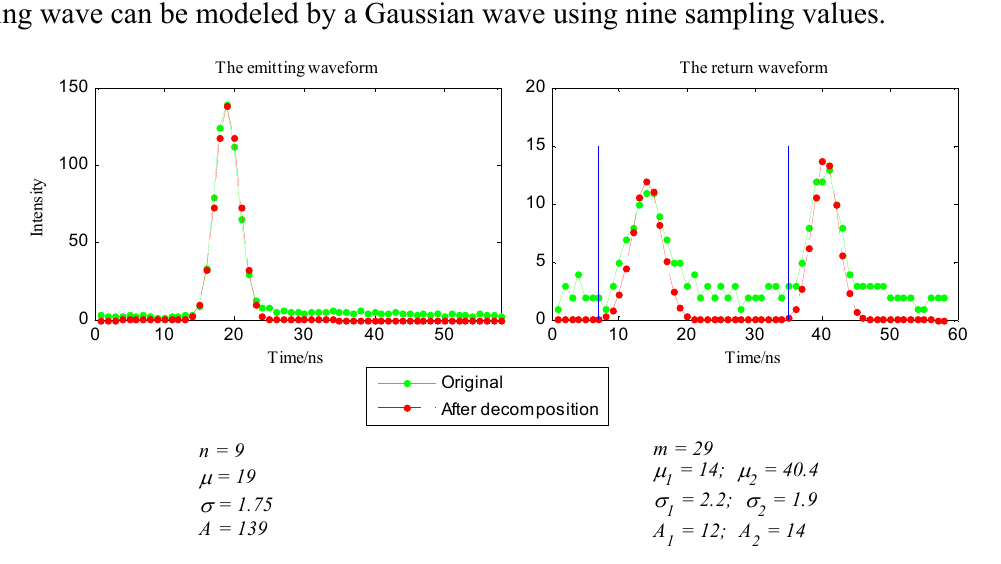
Figure 4. A pair of emitting and return waveforms before and after Gaussian